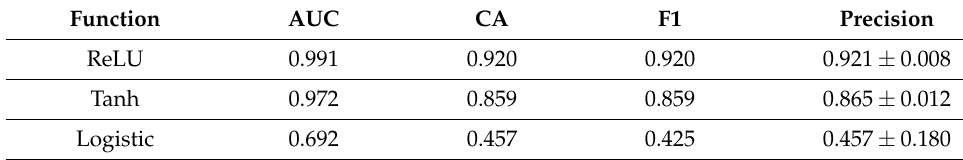
Table 3. the best results after the M3GP transformation of the